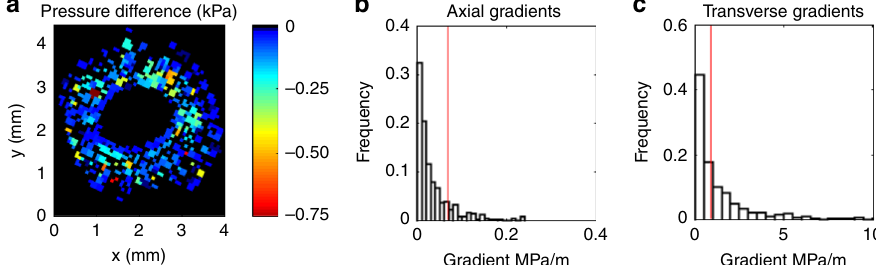
Fig. 6 Axial and transverse pressure gradients. a Pressure difference (kPa, colour scale) imposed on vessels between top and bottom of the stem in the best- fi t model, downsampled to 78 µ m resolution. b Histogram of resulting axial pressure gradients across the stem; red line indicates fl ow-weighted mean value. c Histogram of transverse pressure gradients across adjacent pixels in the top slice of the stem domain; red line indicates mean